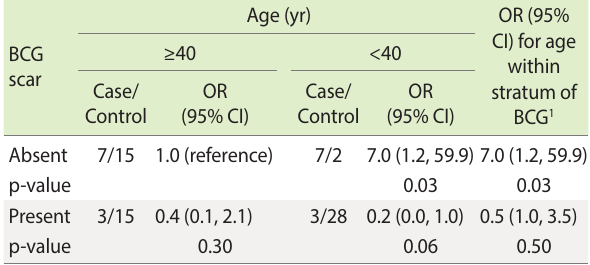
BCG, Bacillus of Calmette and Guérin; OR, odds ratio; CI, confidence